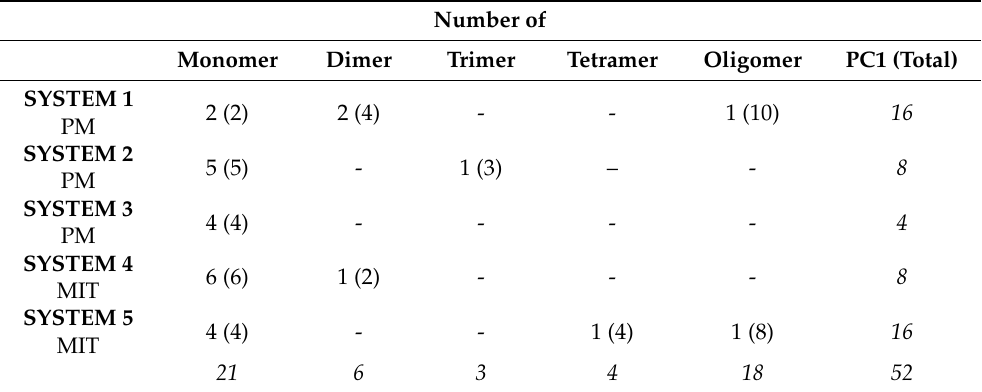
Table 2. Number of oligomer types and number of molecules forming them (in parenthesis) for the five systems studied in this work